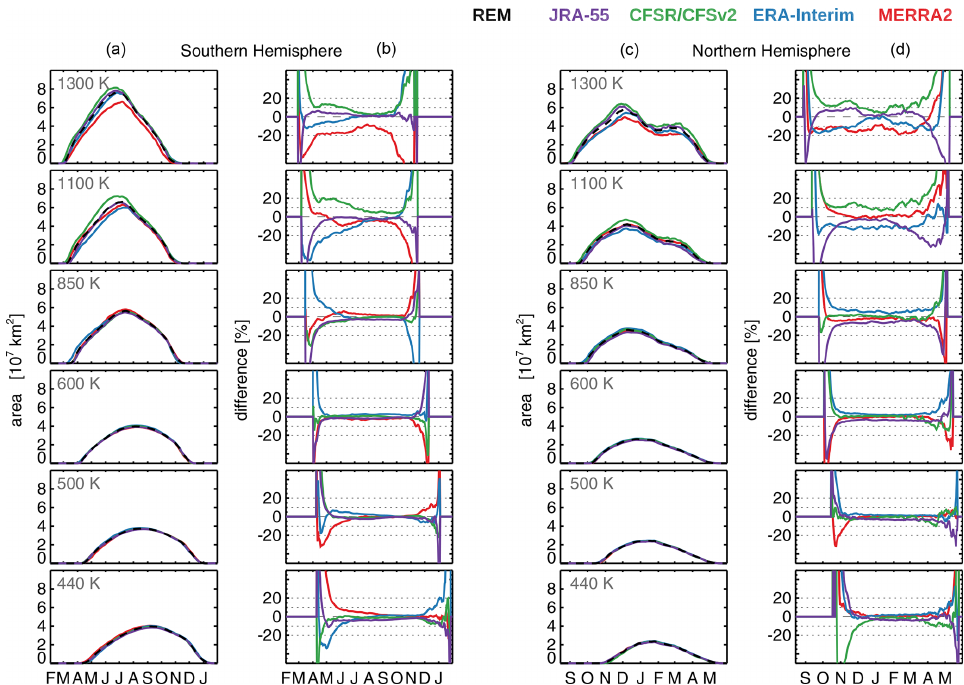
Figure 12. Primary (i.e., largest) polar vortex area seasonal evolution during 2005–2014 in the Southern Hemisphere (a, b) and Northern Hemisphere (c, d) . Right column for each hemisphere shows differences with respect to the REM; as a guideline the dashed gray lines show ± 10% and ± 20% differences.